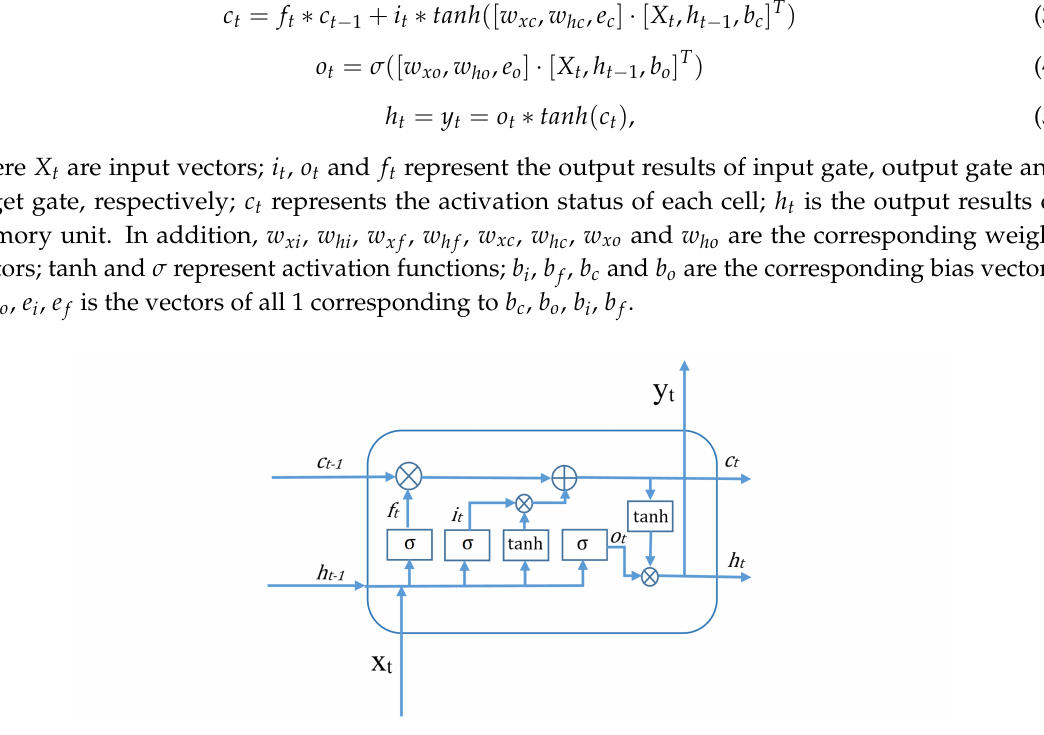
Figure 3. The basic structure of long short term memory (LSTM)